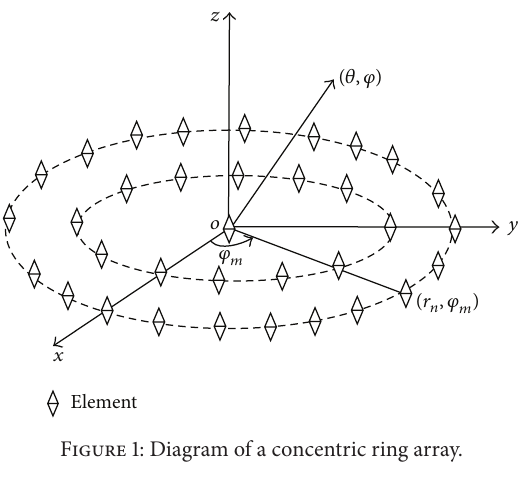
Figure 1: Diagram of a concentric ring